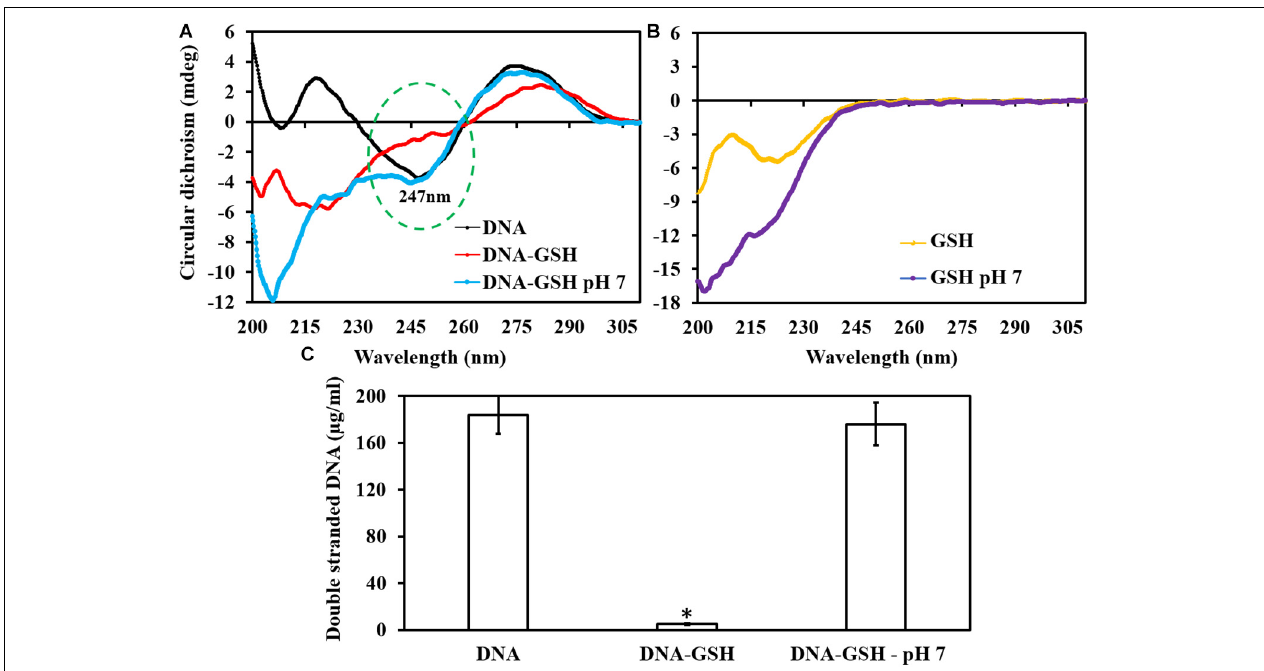
FIGURE 4 | Effect of GSH on dsDNA. The circular dichroism curve showed dsDNA modulation at its sugar phosphate backbone. (A) dsDNA has a peak at 247 nm at intrinsic pH, and no change occurs when it is exposed to GSH at pH 7.2. (B) Intrinsic and buffered GSH curve showed a peak at around 220 nm. (C) Qubit fluorometer quantification of dsDNA showed significant reduction in dsDNA concentration when exposed to GSH at intrinsic pH. ∗ P < 0.05 when compared to control and GSH at neutral pH.